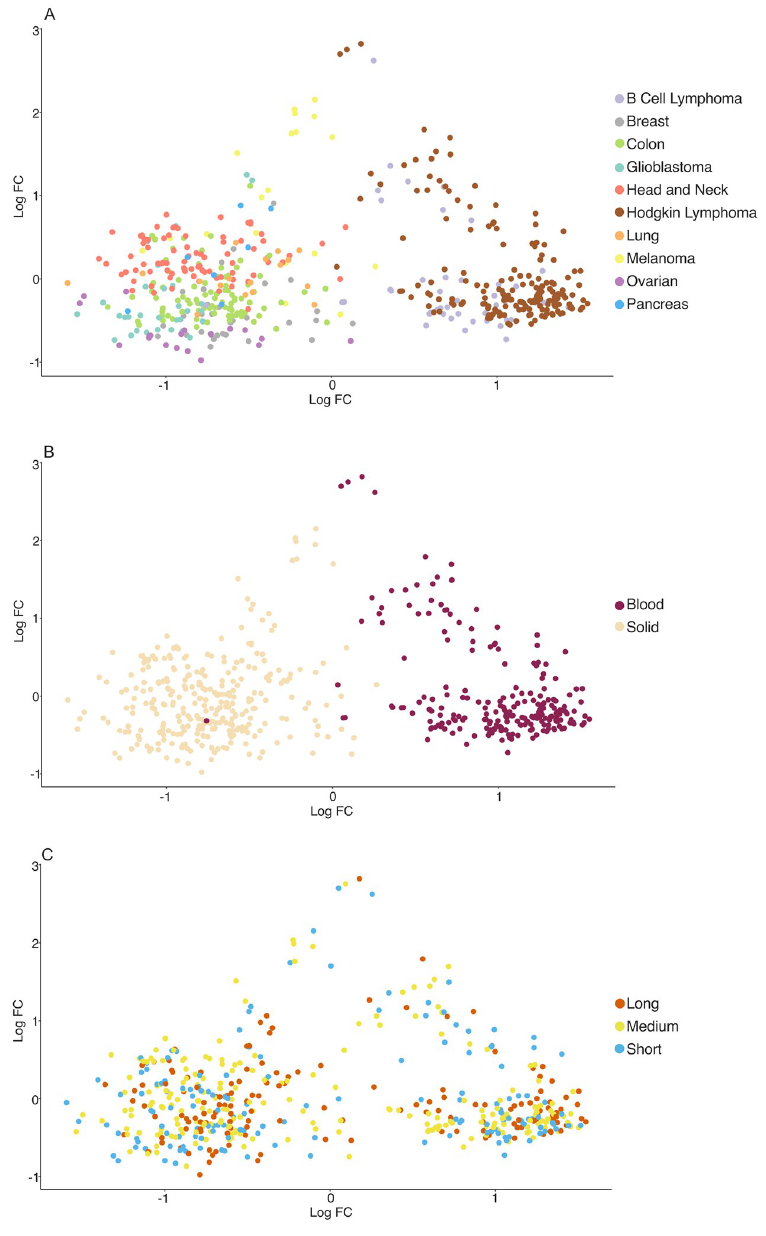
Fig 2. Clustering by cancer type, classification and survival. Multidimensional scaling (MDS) plots showing dissimilarity of patients based on their gene expression profiles (panels A, B and C). (A) MDS plots of patients grouped according to cancer type (ANOSIM with 1000 permutations, P < 0.0001, R = 0.7). (B) MDS plot of patients grouped according to cancer classification (solid and blood: ANOSIM with 1000 permutations, P < 0.0001, R = 0.5). (C) MDS plot of patients grouped according to survival rate (ANOSIM with 1000 permutations, P > 0.05). The clustering observed in panels A and B indicates that patients with the same cancer type and/or cancer class (solid and blood malignancies) tend to show similar gene expression levels. However, no clustering is observed in panel C, indicating that gene expression level and survival rate are not correlated.